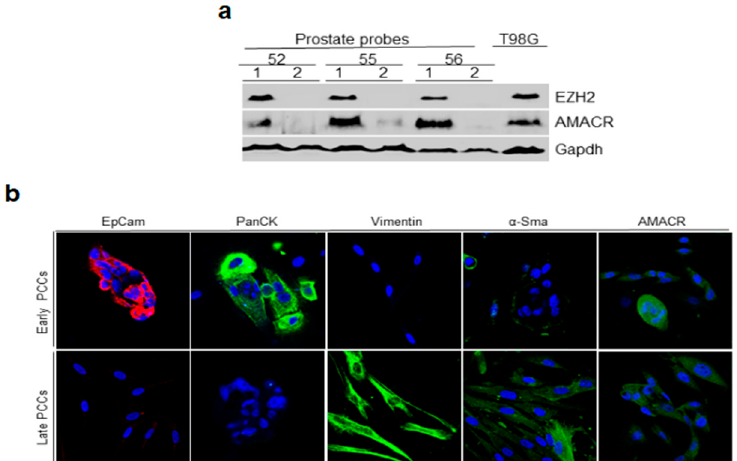
Figure 2. Immunoblotting and immunofluorescence staining of the epithelial, mesenchymal, and cancer markers in the prostate tissue and early and late PCCs derived from PCaT. ( a ) Immunoblotting of prostate cancer markers AMACR and EZH2 in cancerous (1) and normal (2) tissues. Protein extracts (30 µg of total protein per lane) were loaded onto 10% polyacrylamide gel. The extract of T98G cells served as a positive control, Gapdh was used as a loading control; ( b ) early and late PCCs were stained with antibodies against epithelial (EpCam, PanCK), mesenchymal (vimentin, α -Sma), and cancer (AMACR) markers. Images were captured with a digital scanning confocal microscope (Leica Microsystems, Wetzlar, Germany) using 405, 488, 543 and 633-nm lasers, objective, ×63.